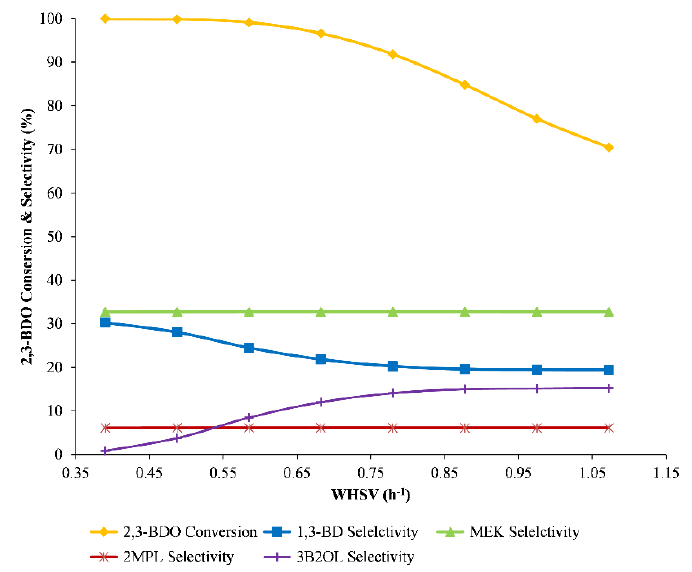
Figure 8. The influence of WHSV on reactor performance.